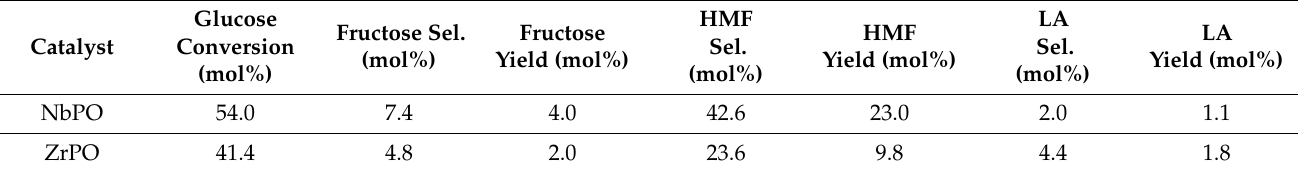
Table 4. MW-assisted conversion of glucose carried out in the presence of ZrPO catalyst. The corresponding hydrolysis experiment with NbPO has been reported for comparison. Reaction